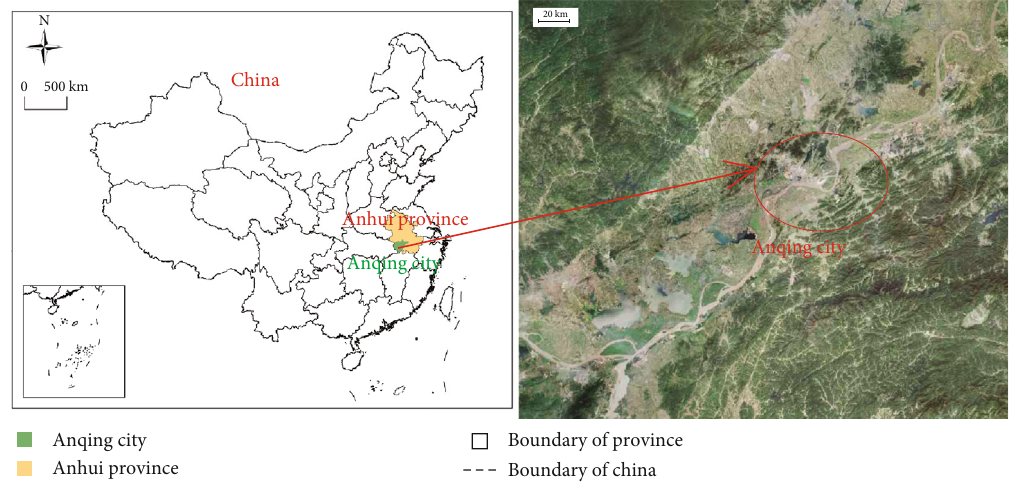
Figure 1: Topographic map of the upper reaches of the Wanjiang River in Anhui Province.